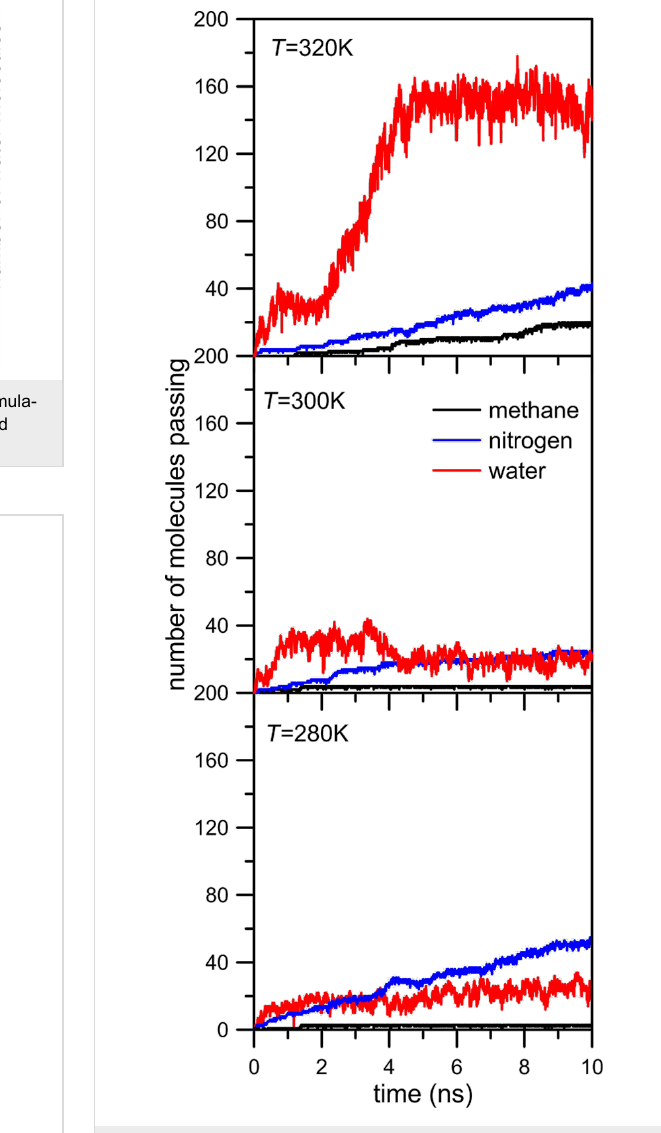
Figure 11: The temperature influence on the number of molecules passing across the pore as a function of the simulation time for CH 4 + N 2 + 200 H 2 O separation with an NN